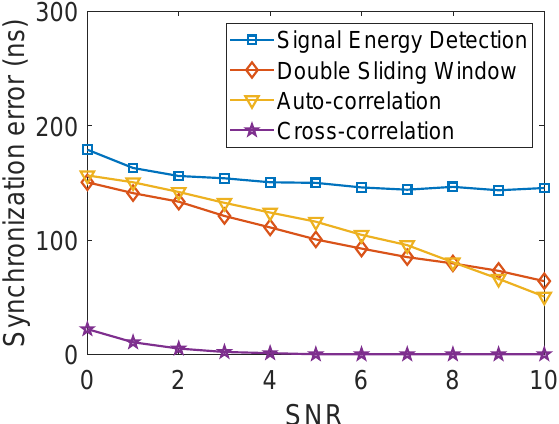
Figure 20. Synchronization error time for four